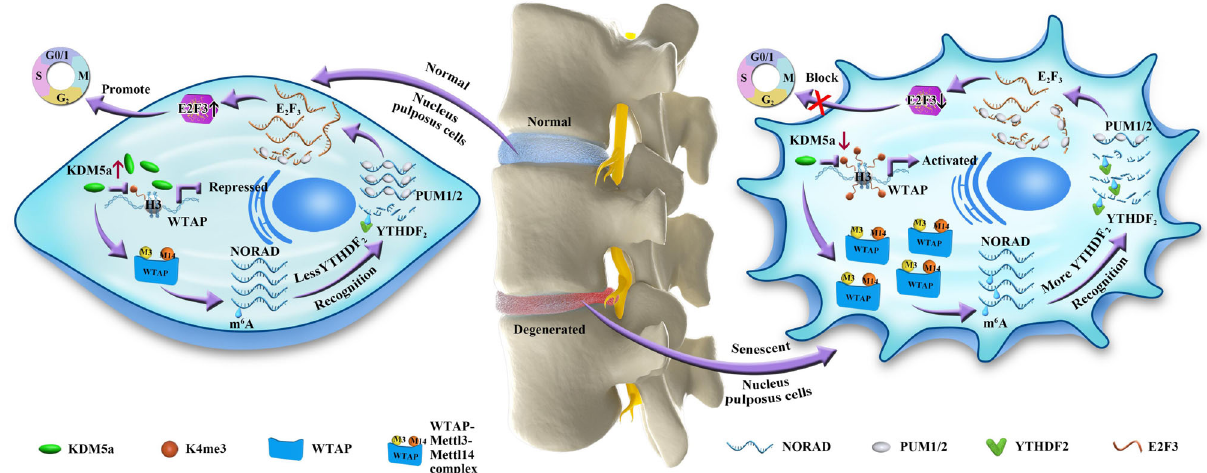
Fig. 9 Schematic representation of the mechanisms via which m 6 A modi fi cation mediates NPC senescence and IVDD progression. In senescent NPCs, downregulated KDM5a enhances H3K4me3 modi fi cation of the WTAP promoter and promotes WTAP expression. WTAP promotes m 6 A modi fi cation of NORAD and induces degradation of NORAD transcripts by YTHDF2 recognition. Less NORAD results in less sequestered RNA-binding proteins PUM1/2, leading to more binding of PUM1/2 to E2F3 mRNAs. This leads to more recognition of PUM1/2 and degradation of E2F3 transcripts, promoting the senescence of